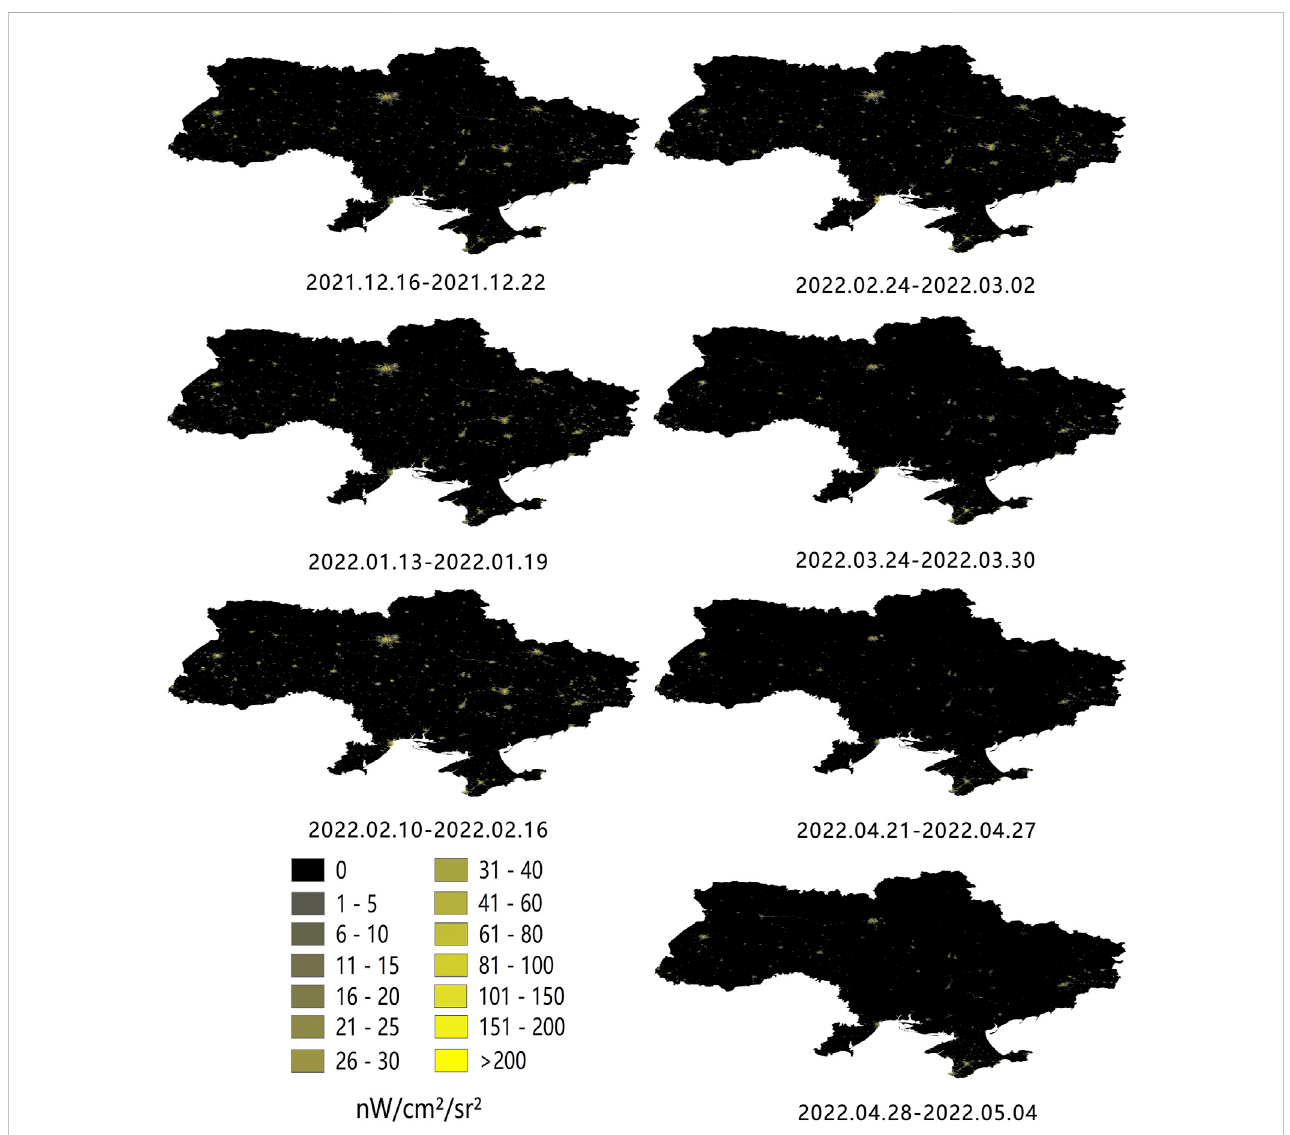
FIGURE 2 Ukrainian nighttime light spatial changes from 16 December 2021 to 2 May